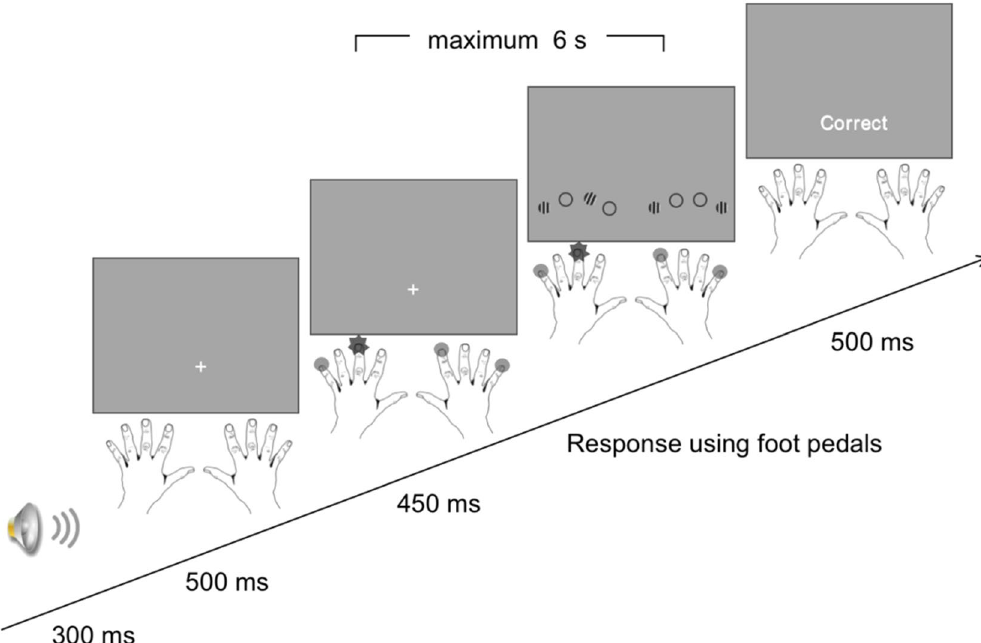
Figure 2. An example stimulus sequence of a visual-tactile search display from the multisensory session. After the initial auditory beep, tactile stimuli were presented for 450 ms prior to the onset of the visual items. The dark ‘star’ represents the tactile singleton (target) finger, and the light grey disks the non-singleton (distractor) fingers. The four visual items were Gabor patches presented at, relative to the fingers, corresponding locations. The visual target was the single left- vs. right-tilted Gabor patch, amongst the three vertical distractor Gabor patches. Observers’ task was to discriminate the orientation of the visual Gabor target by pressing the corresponding foot pedal. A feedback display (together with a warning beep in case of an erroneous response) was presented after the response. The maximum stimulus duration was 6 s. In the unisensory session, only visual Gabor items (and the rings) were